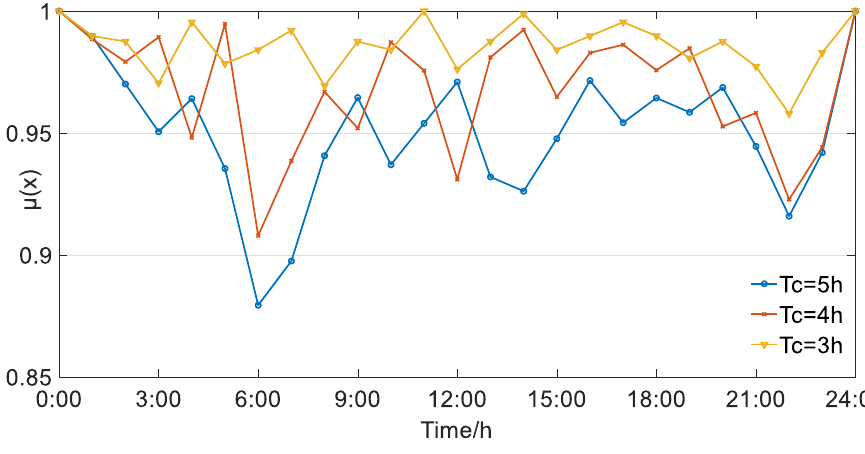
Figure 18. The impact of DR on the thermal dispatch cycle.